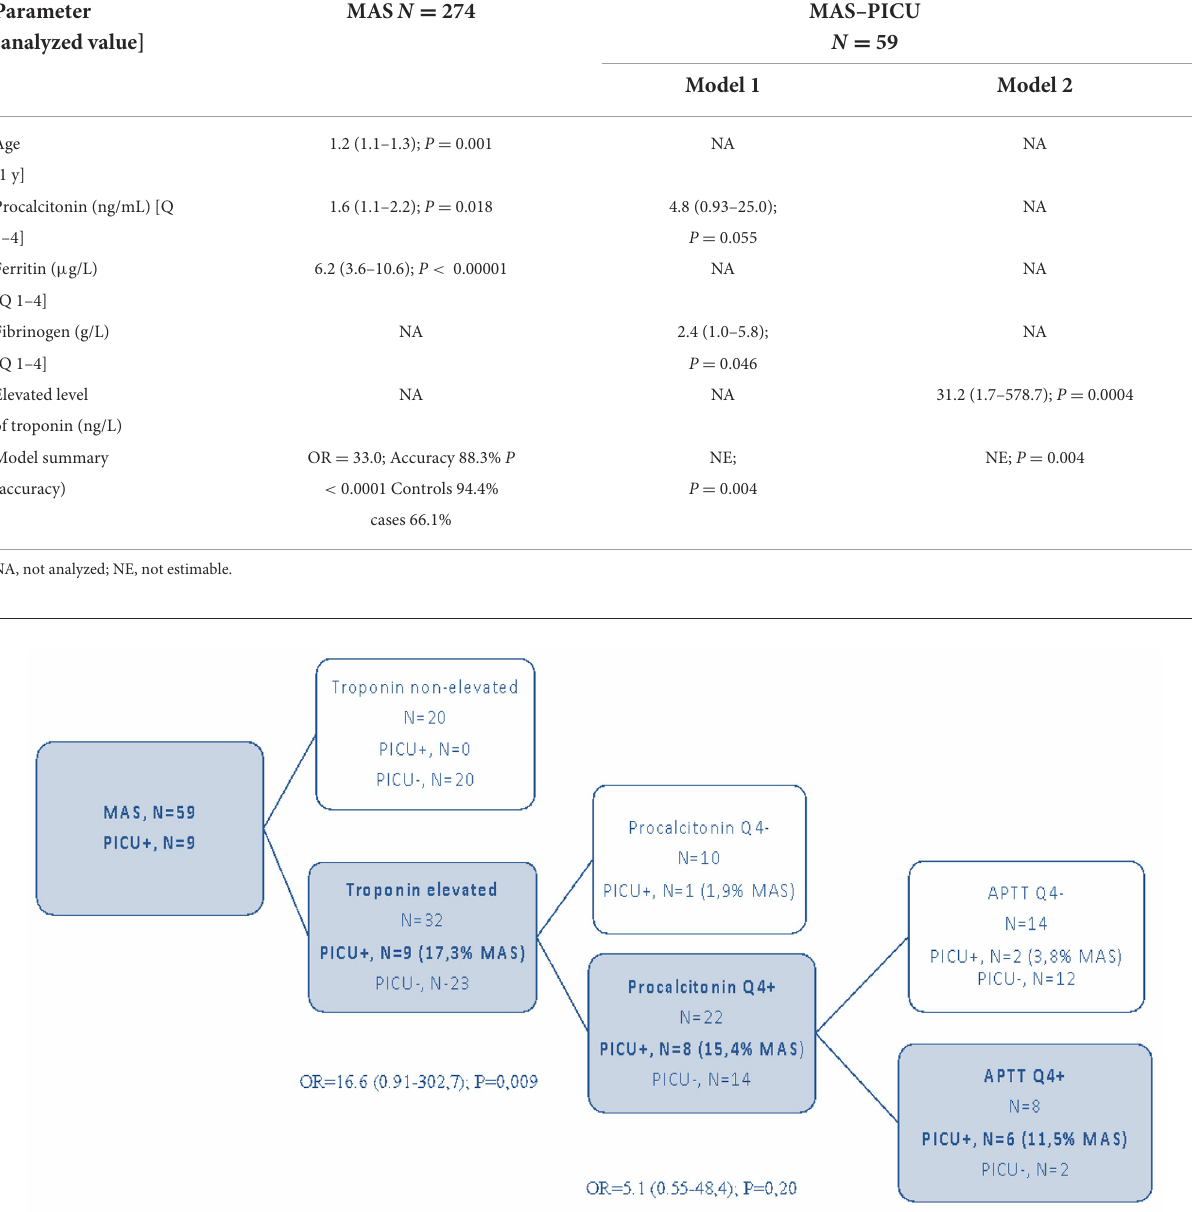
pathway of impaired cytotoxicity leading to cytokine storm